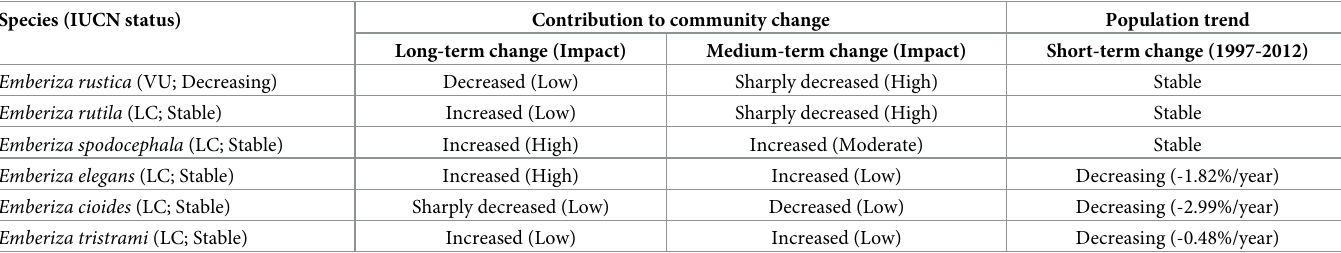
Table 4. Six main Emberiza species have caused changes in bunting communities and populations in Korea over time. The International Union for Conservation of Nature (IUCN) status in parentheses indicates the Red List Category and its population trend as of March 2020 (VU: Vulnerable, LC: Least Concern). Species (IUCN